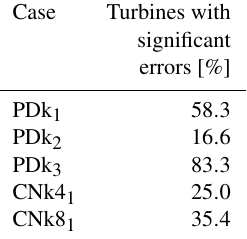
Table 5. Comparison of percentage of turbines with statistically significant errors based on 95% confidence intervals between LES simulations and field measurements.